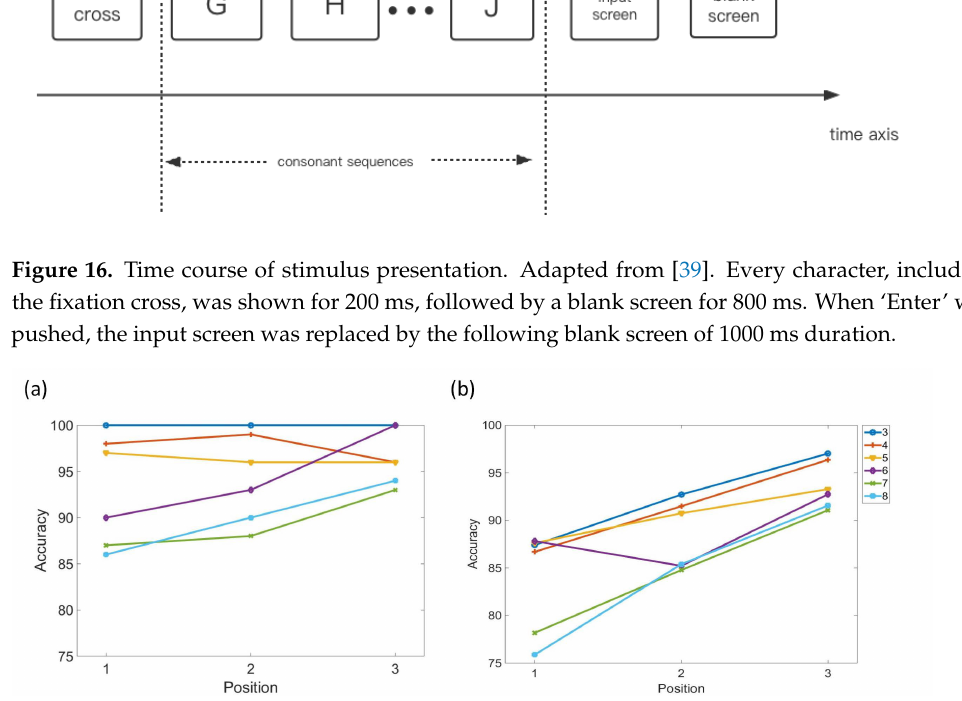
Figure 17. Comparison of the results of SDN and humans in a test devised by Kusak et al. ( a ) The results of Kusak et al.’s experiment. ( b ) Our model simulation